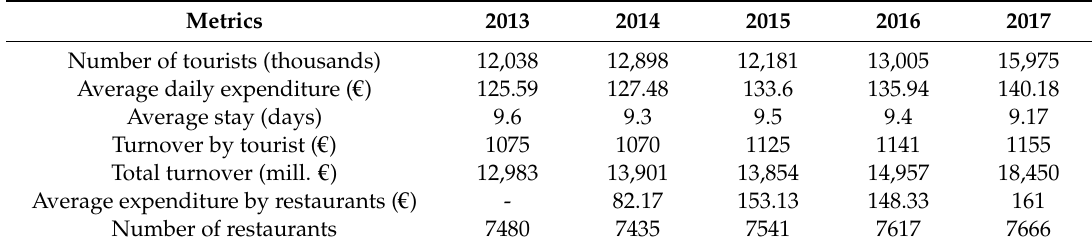
Table 1. The Canary Islands as a gastronomic tourist destination.